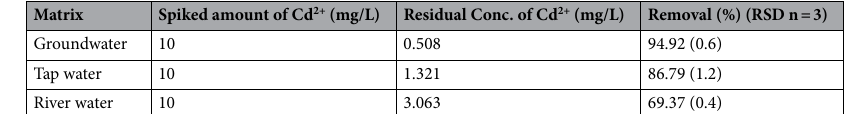
Table 9. Cadmium ion removal from a real water matrix after spiking cadmium.